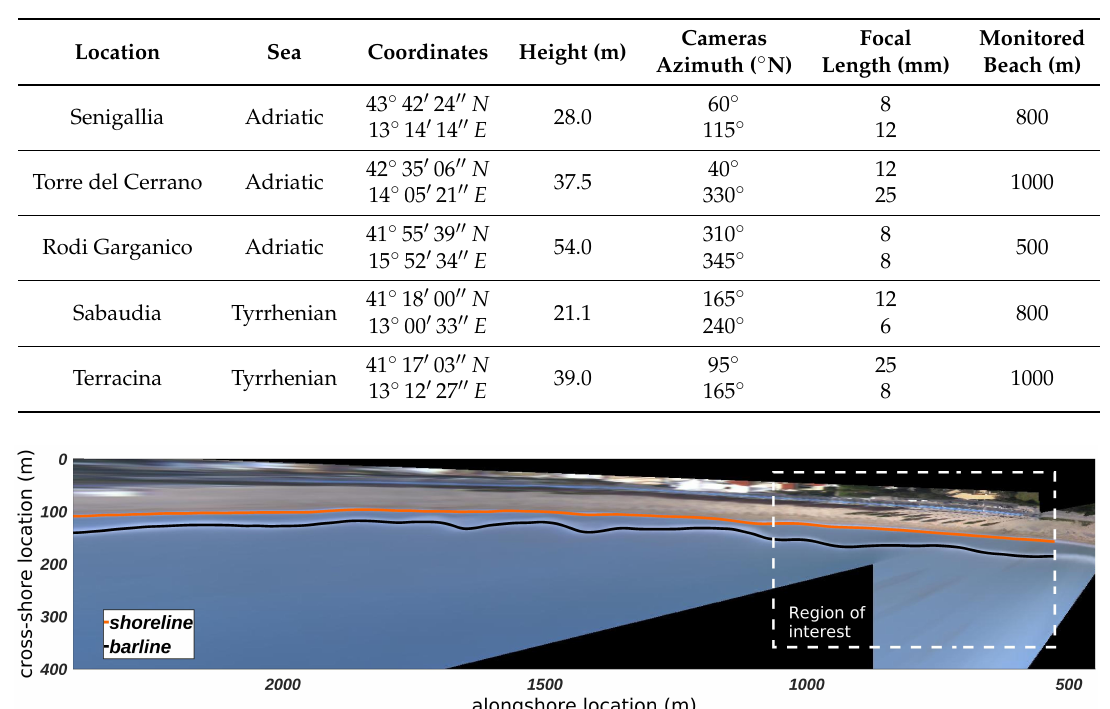
Table 1. Specifics of the deployed video-monitoring stations.